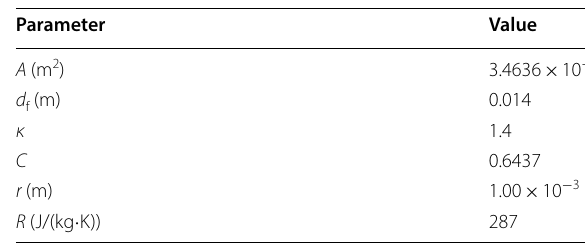
Table 3 Known parameters in Eq.